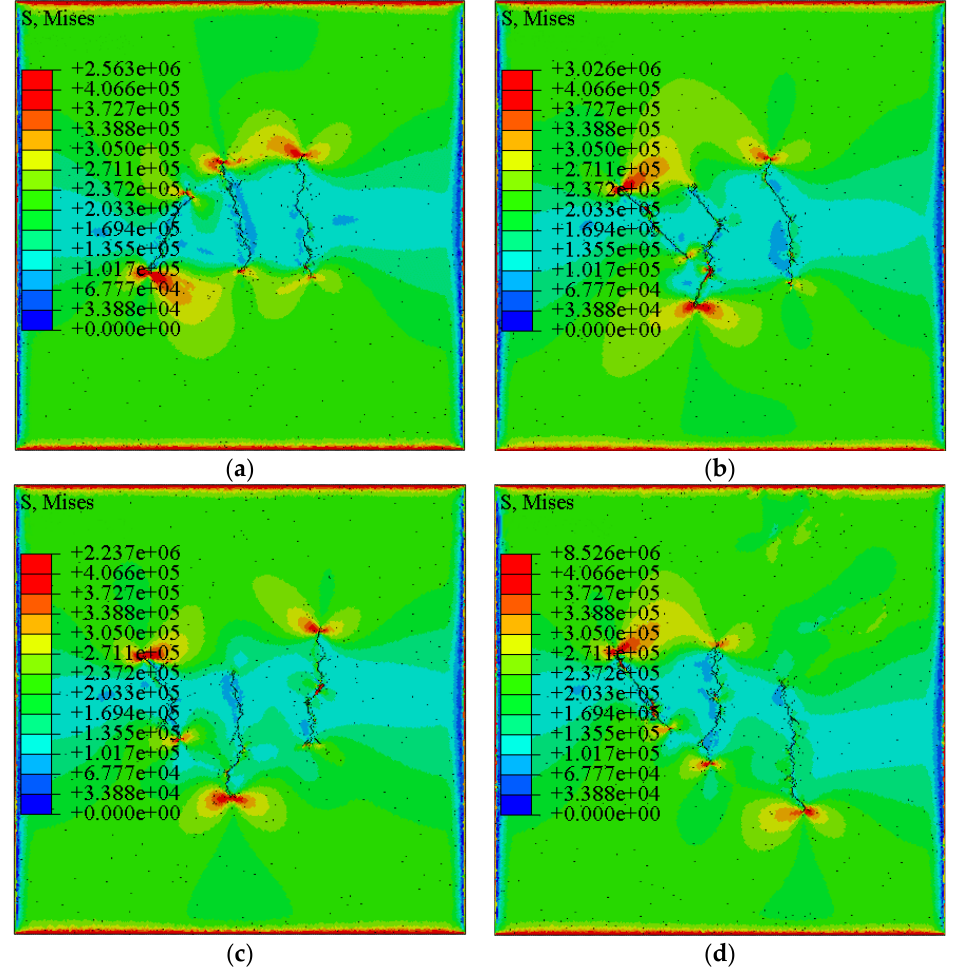
Figure 9. Von Mises stress distribution during staged fracture propagation in CBM reservoirs under various fractal dimensions of natural joints. ( a ) 1.2662, ( b ) 1.2716, ( c ) 1.2806, ( d ) 1.2998.